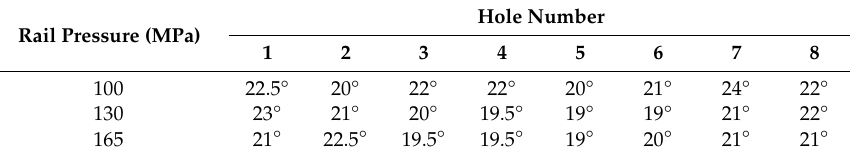
Table 3. The cone angle of the fuel sprays of nozzle 2. Table 2. The cone angle of the fuel sprays of nozzle 1.